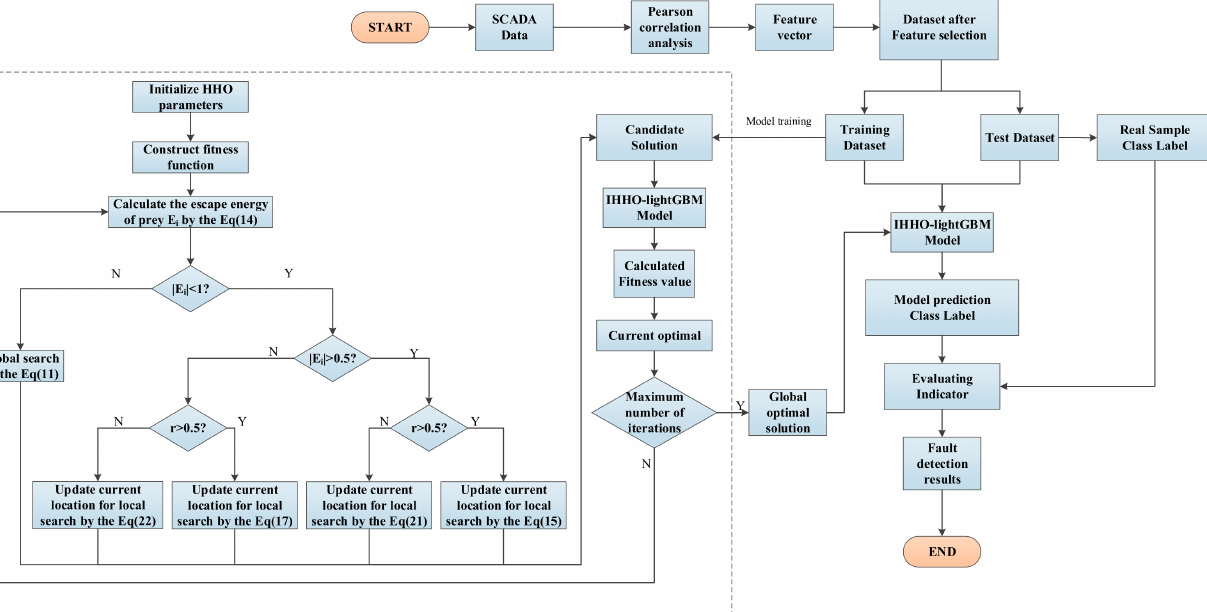
Figure 5. Fault detection flow chart of wind turbine pitch system based on improved